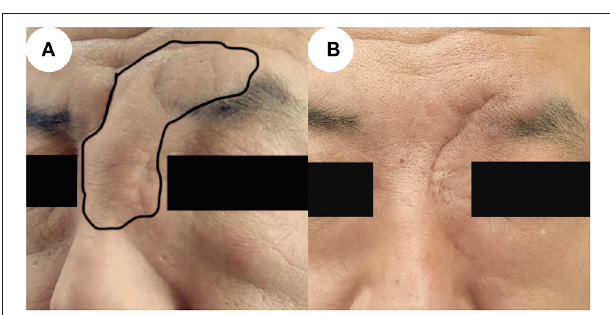
FIGURE 3 | Images before and after surgery. (A) Photo taken prior to surgery, showing the local updrift at the nasal forehead which in the black circle. (B) Six months after surgery, the area is of normal appearance without